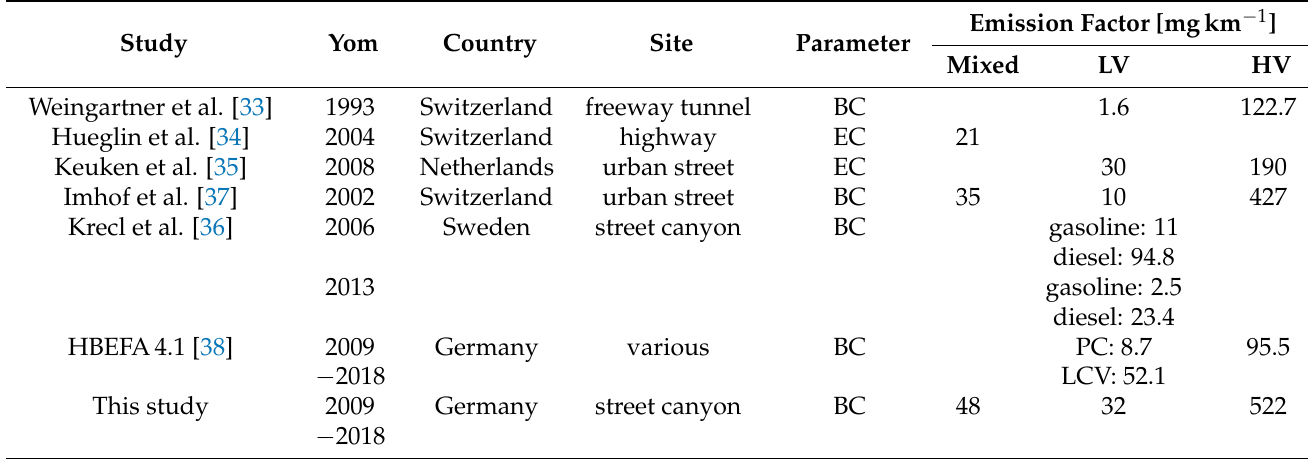
Table 1. Black carbon (BC)/ elemental carbon (EC) emission factors derived from different studies (Yom = year of measurement) and calculated from the Handbook Emission Factors for Road Transport (HBEFA). EFs, if available, are given for the mixed fleet vehicle and/or light vehicle & heavy vehicle. HBEFA distinguishes between passenger cars (PC) and light commercial vehicles (LCV).